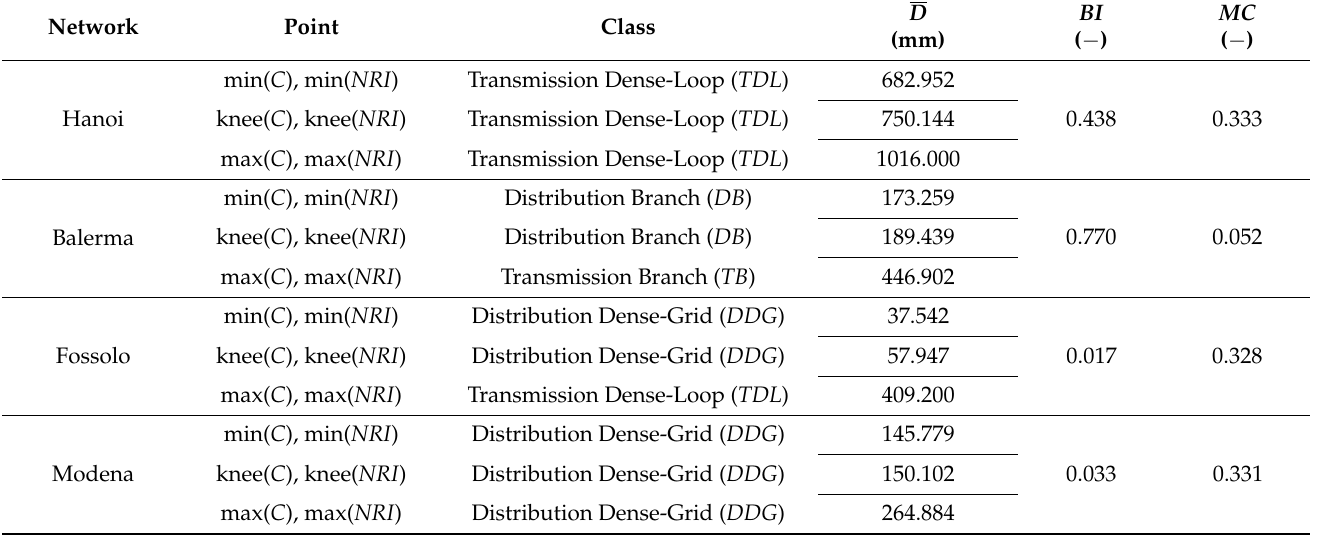
Table 4. WDS classification, according to Hwang and Lansey [36]. D represents the length-weighted average pipe diameter, BI is the Branch Index, and MC is the Meshedness Coefficient for the reduced network.